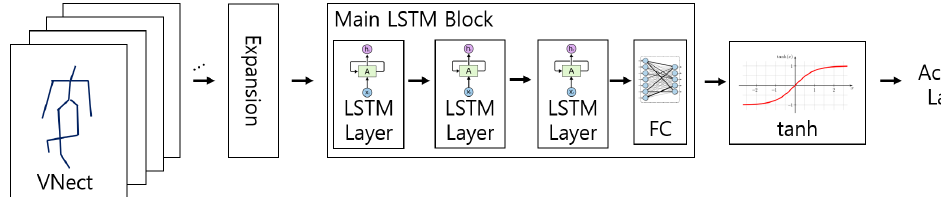
Figure 5. Proposed network for activity recognition using pose estimation. FC refers to the fully connected layer at the end of the main LSTM block.